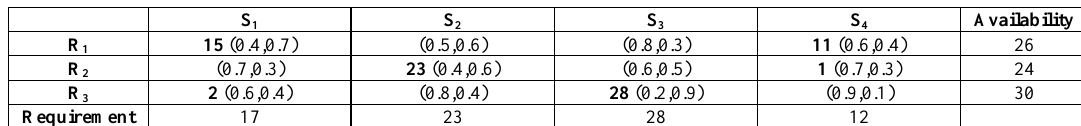
Table 2. Attained IFBFS.